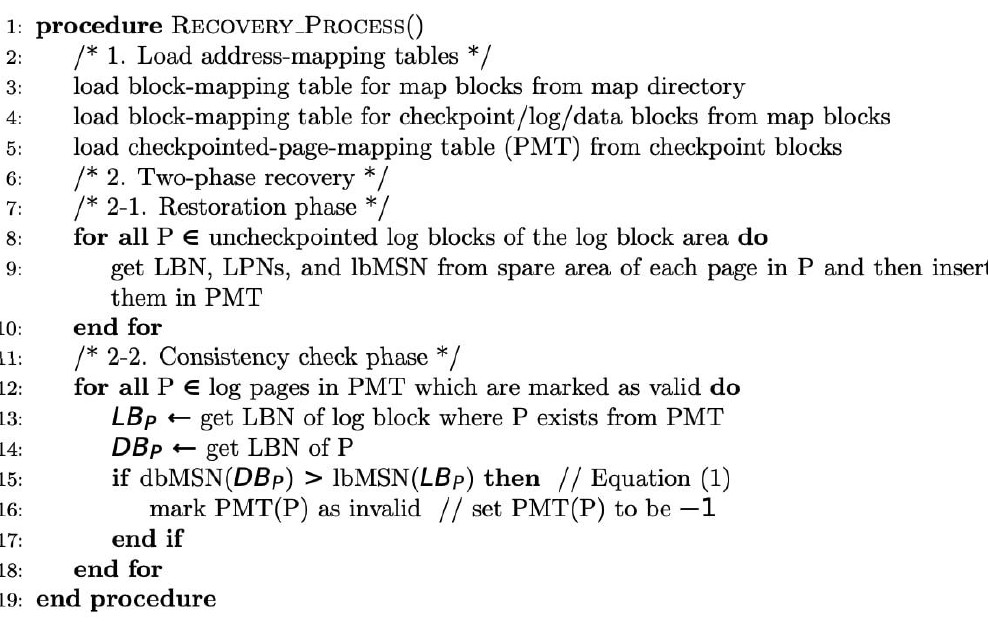
Figure 6. Two-phase recovery algorithm.